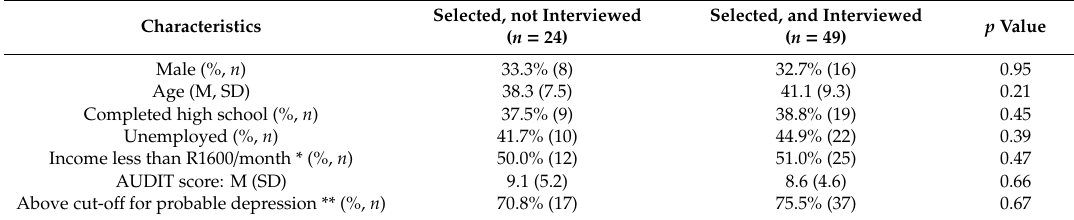
Table 2. Demographic and clinical characteristics of